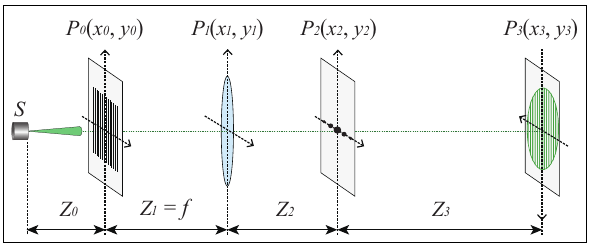
Figure 1. Sketch of the sinusoidal optical signal